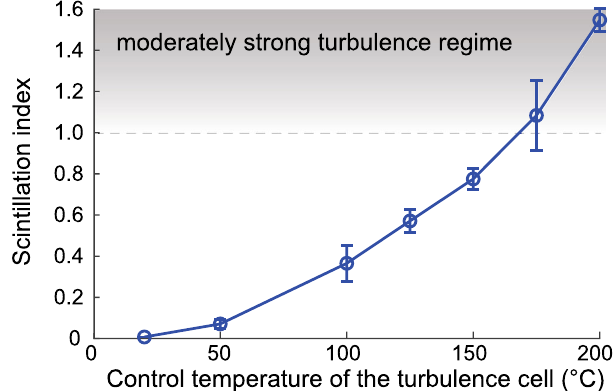
Fig. 4 Measured scintillation index. Measured scintillation index of Gaussian beams propagating through the turbulence cell as a function of the control temperature. Error bars represent standard deviation over three independent measurements.